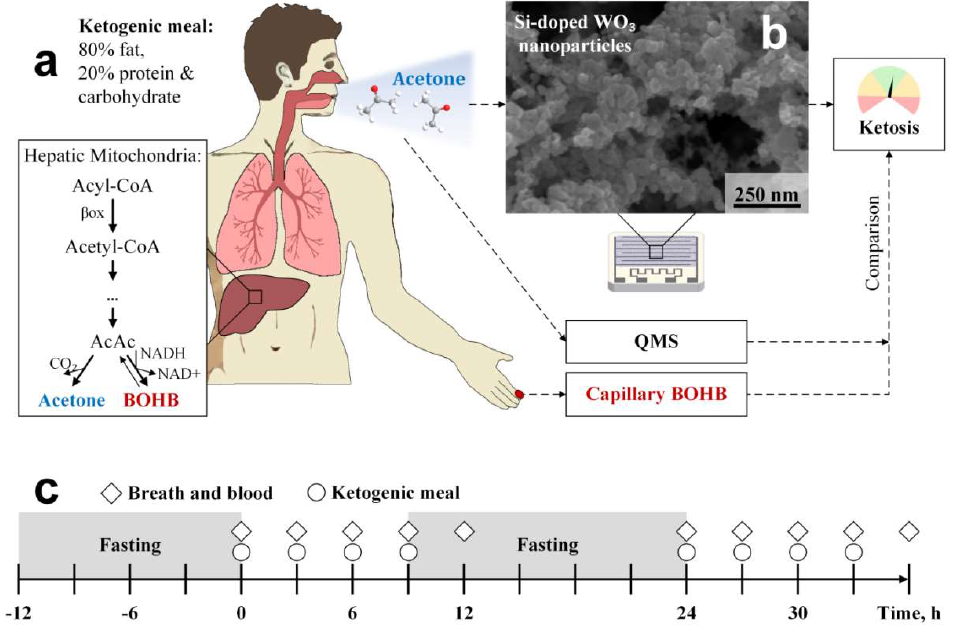
Figure 1. ( a ) Participants undergoing a KD feature intensified ketogenesis. Therein, acetone and BOHB are formed at elevated rates by metabolizing free fatty acids in the hepatic mitochondria (box). Acetone is volatile and can be measured non-invasively in the exhaled breath while non-volatile BOHB can be determined through capillary blood assay. To indicate the status of ketosis, breath acetone is measured with tailor-made and inexpensive chemoresistive sensing films ( b ). These consist of agglomerated and aggregated Si-doped WO 3 nanoparticles, as indicated by SEM (top view). Sensor results are compared to parallel measurements of breath acetone by QMS and capillary blood BOHB. ( c ) Experimental protocol: Volunteers ingest a total of 8 ketogenic meals every 3 h (circles) on two consecutive days. Breath and capillary blood are analyzed 10 times, always just before the ketogenic meals and at the end of each measurement day. Prior to and in between both days, overnight fasting (gray shaded) is performed.